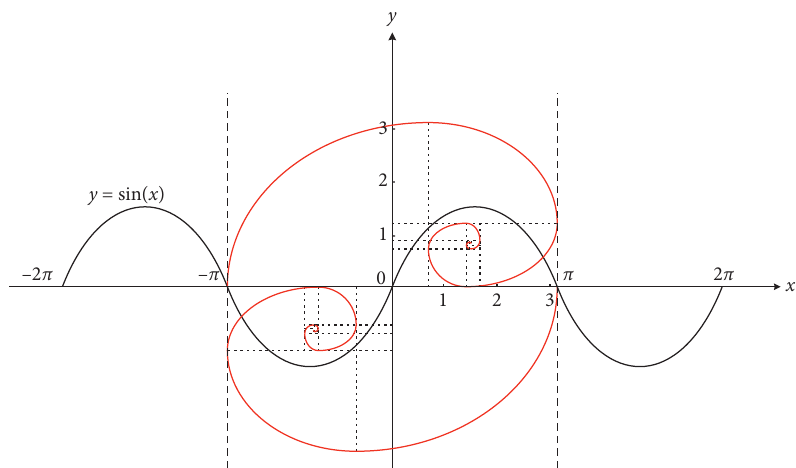
Figure 3: Golden sine curve in two-dimensional